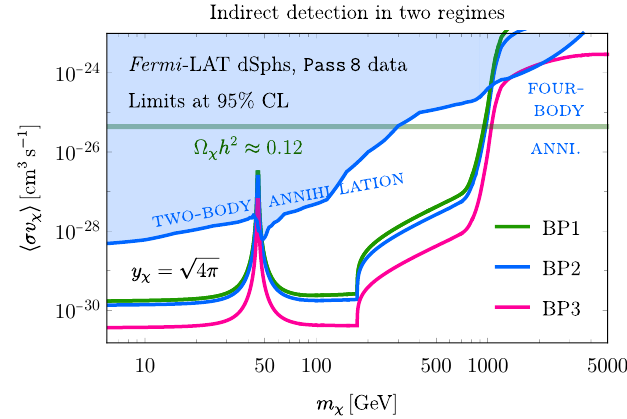
Figure 17 . Limits on DM annihilation from γ -ray emissions from Local Group dwarf spheroidal galaxies (dSphs) observed by the Fermi -LAT collaboration. Annihilation rates are displayed for all √ benchmarks with maximal coupling y χ = 4 π